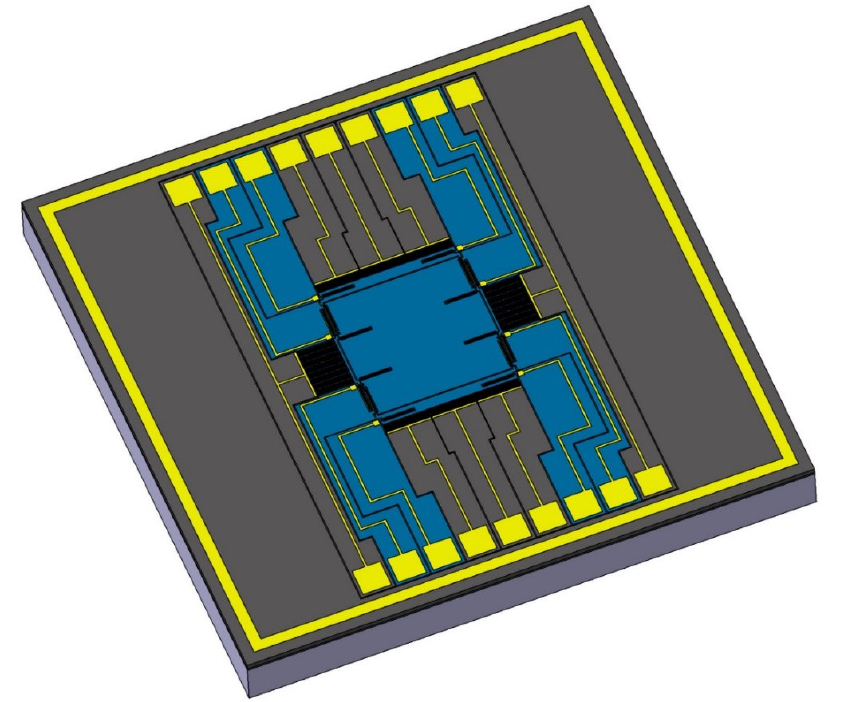
Figure 28. The final model of the SE of the MEMS